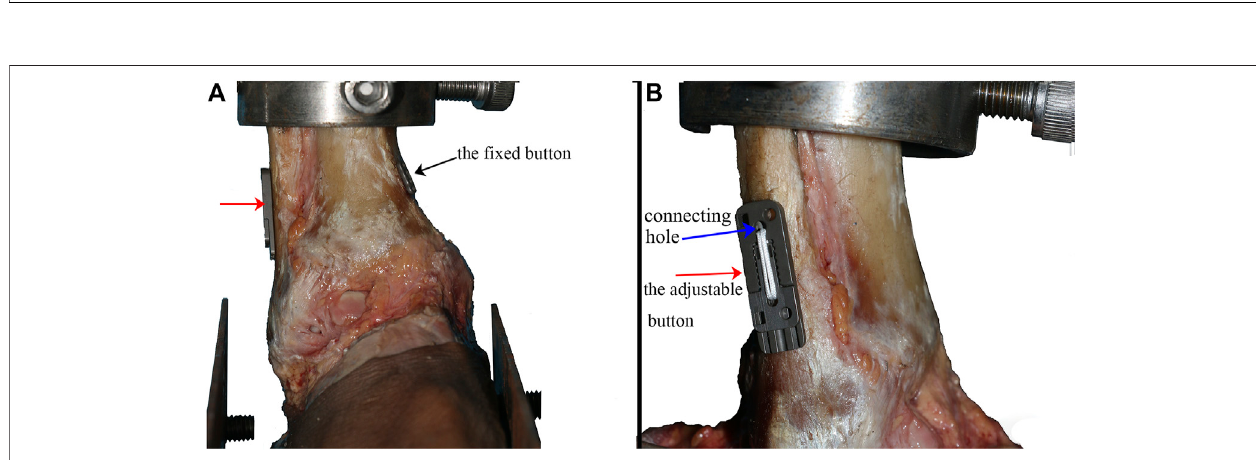
FIGURE 4 | Specimen fi xed with the NAE (the black arrow showed the fi xed button, the red arrow showed the adjustable button, and the blue arrow showed the connecting holes in the adjustable button) (A) observed from the front side and (B) observed from the fi bula